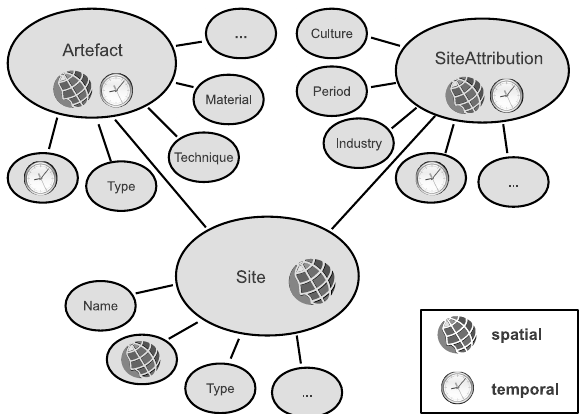
Figure 2: Generalized graph representation of the archaeological data model.